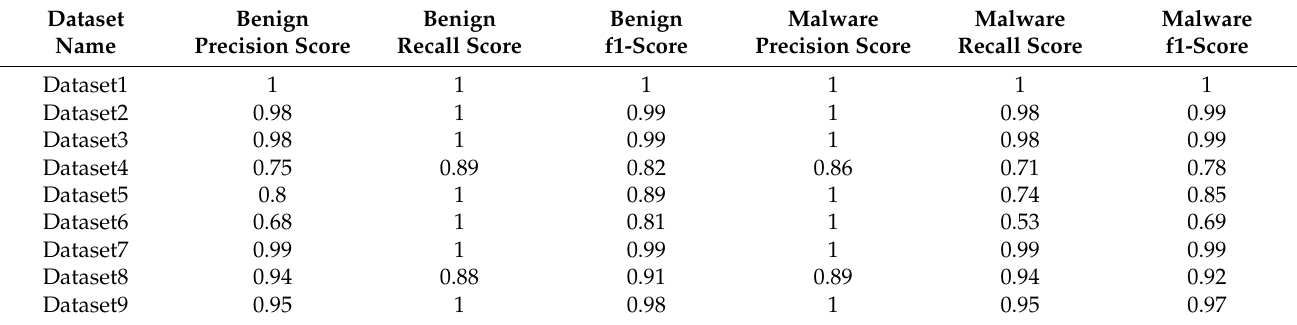
Table 5. Test results when using the random forest algorithm.